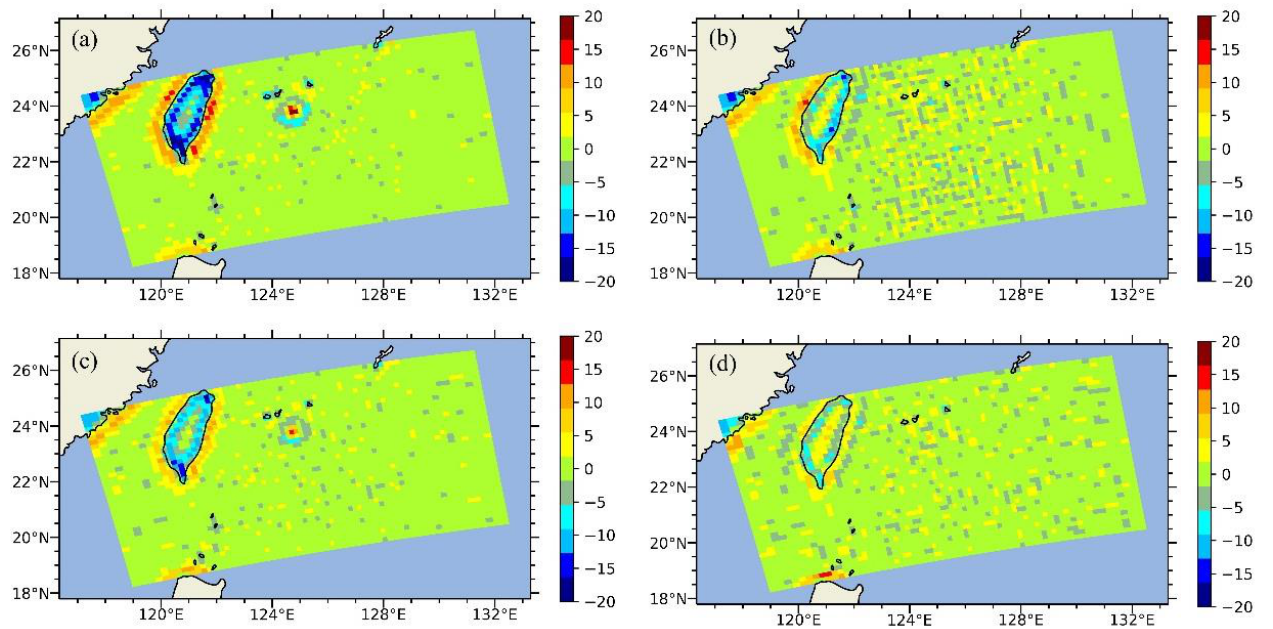
Figure 7. Brightness temperature differences between ( a ) 5.2° simulations and truth value (Figure 6a,b); ( b ) brightness temperature differences between results resampled by BGI and truth value (Figure 6b,c); ( c ) brightness temperature differences between results resampled by AAPP and truth value (Figure 6b,d); ( d ) brightness temperature differences between results resampled by modified AAPP and truth value (Figure 6b,e). The unit of brightness temperature differences is K.